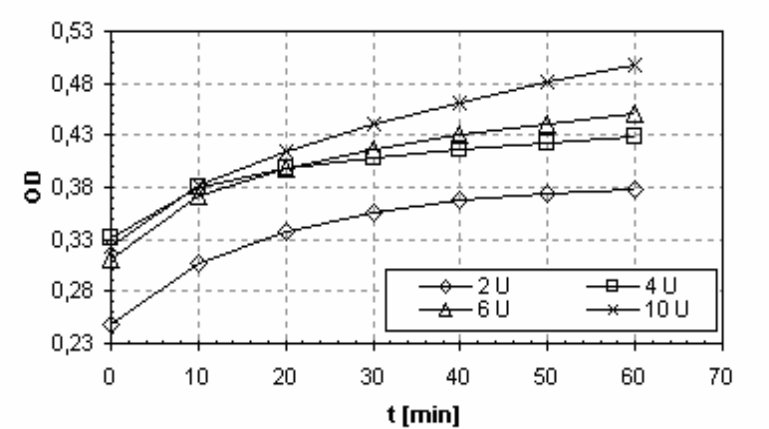
Figure 2. Kinetics of the enzymatic reaction for samples of different enzyme activity levels (2 - 10 U) and constant concentration of the substrate (0.01 M) and the cofactor (0.4 mM). Background buffer solution: EPPS (2.5 mM of pH 7.93).